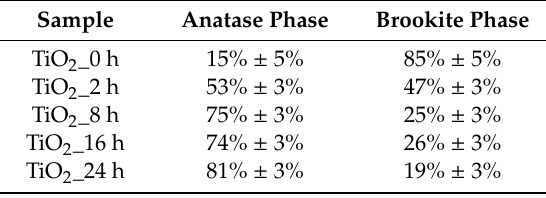
Table 1. Crystallographic composition of the TiO 2 NPs as a function of the duration of the thermal treatment.